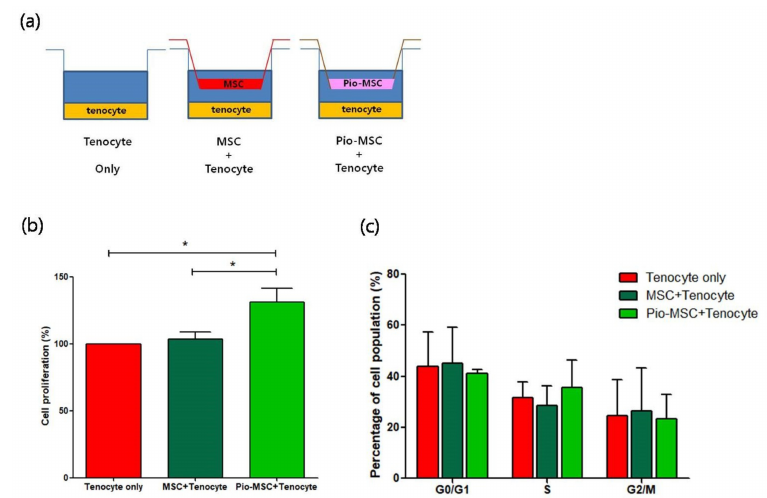
Figure 3. Proliferation profile of tenocytes following co-culture with MSCs or pio-MSCs under an indirect co-culture system. ( a ) Schematic model of the co-culture system of tenocytes with MSCs or pio-MSCs using transwell inserts with a 0.4- µ m porous membrane to separate the cells. Each cell type was grown independently on the transwell plates. ( b ) Tenocyte proliferation analysis using an MTT assay. After 48 h in co-culture with MSCs or pio-MSCs, tenocytes were harvested and their proliferation was calculated and normalized against a tenocyte monoculture (tenocyte only). ( c ) At 48 h co-culturing with MSCs or pio-MSCs, the percentage of tenocytes in each phase of the cell cycle was measured by flow cytometry. All data are expressed as a mean ± standard error (SE) from three replicate experiments. * p < 0.05.